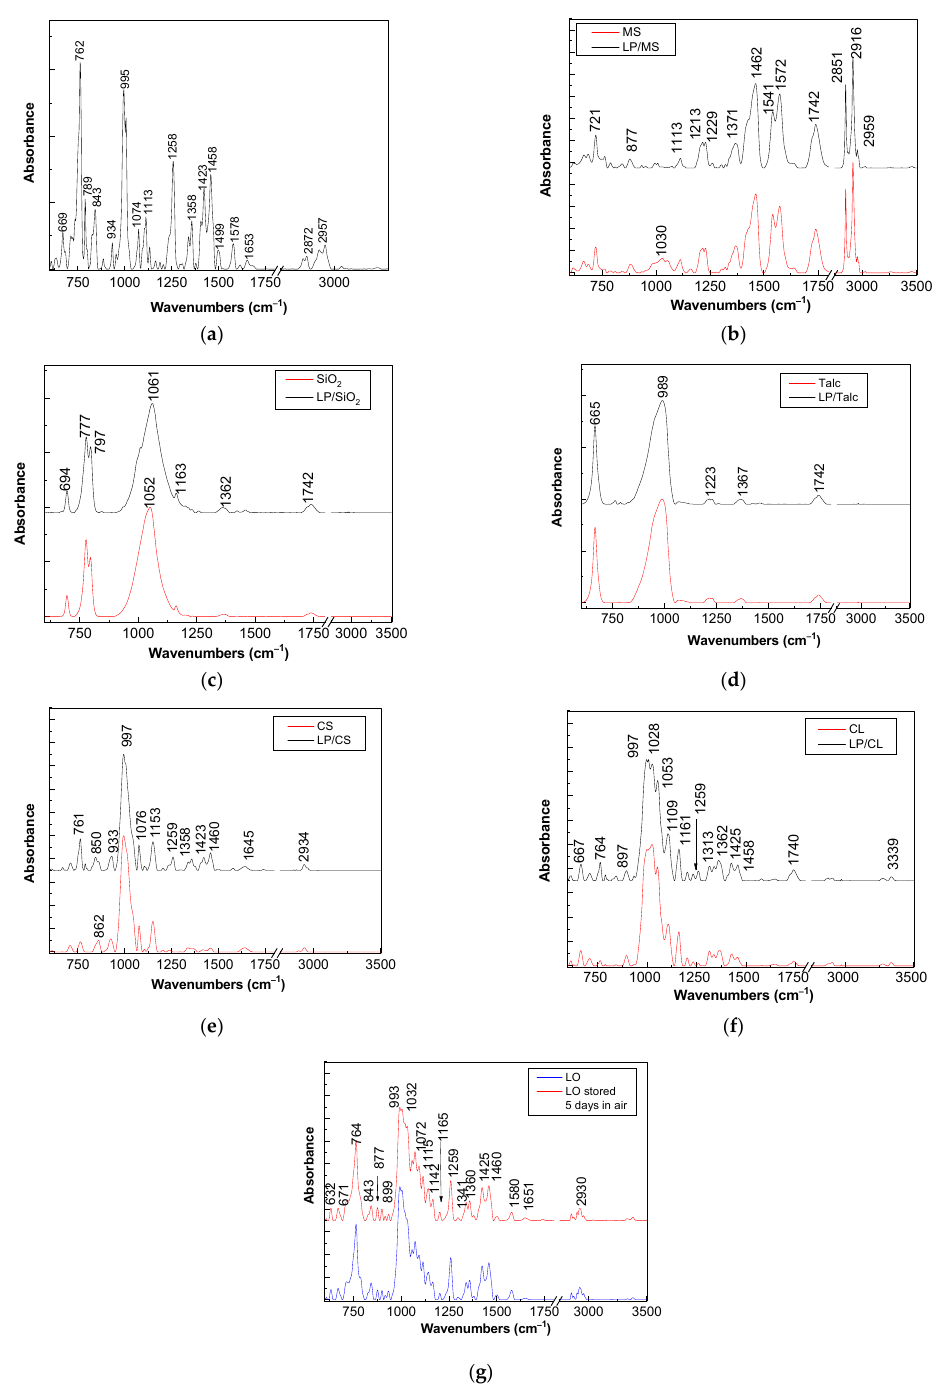
Figure 3. FTIR spectra of the LP ( 1 ) ( a ) and the blends LP ( 1 )/MS ( b ), LP ( 1 )/SiO 2 ( c ), LP ( 1 )/talc ( d ), LP( 1 )/C ( e ) and LP( 1 )/CL ( f ). The red curves in FTIR spectra of Figures ( b – f ), correspond to the following excipients: MS, SiO 2 , talc, CS and CL. Figure ( g ) shows the FTIR spectra of the LO drug, before and after to storage in air, time of 5 day, under UV light.